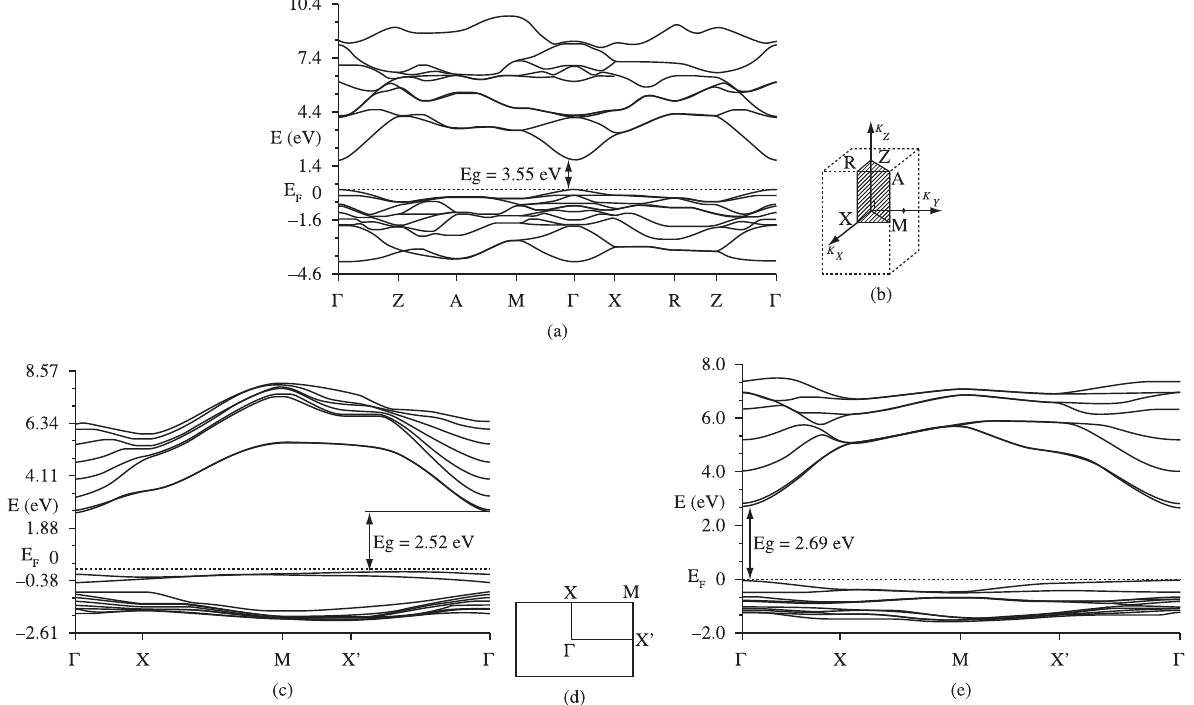
: b) bulk and d) Surface (110) 2